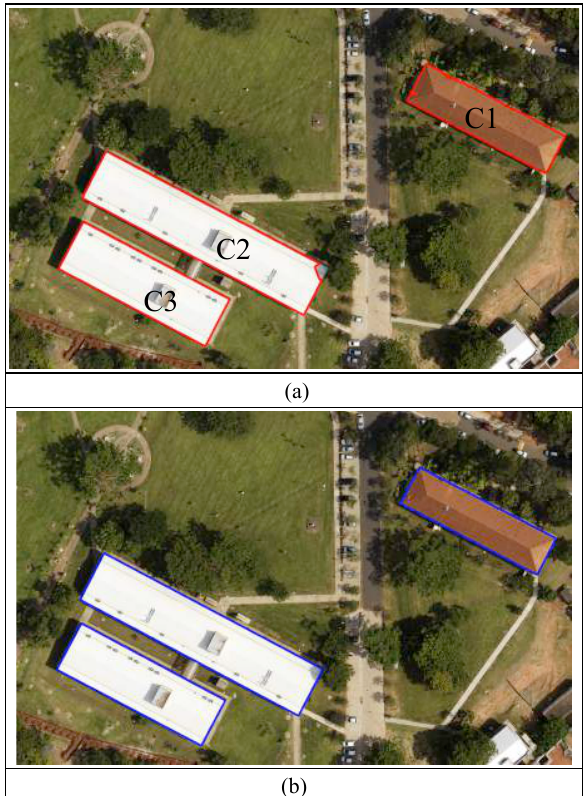
Figure 2. Test 1. (a) Building roof polylines identified by the GA algorithm; (b) Reference building roof boundaries